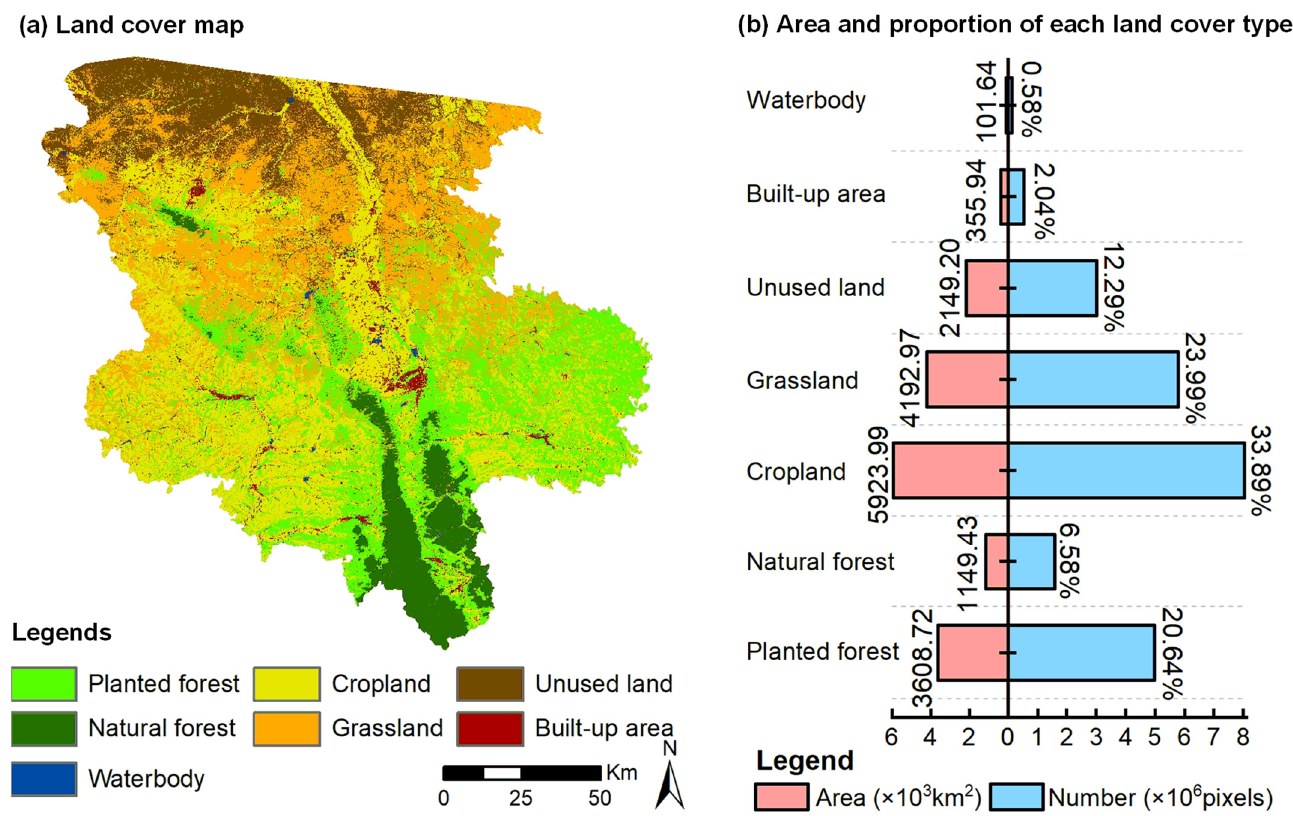
Figure 5. ( a ) Land cover map and, ( b ) area and number of pixels of each land cover type in the study area.